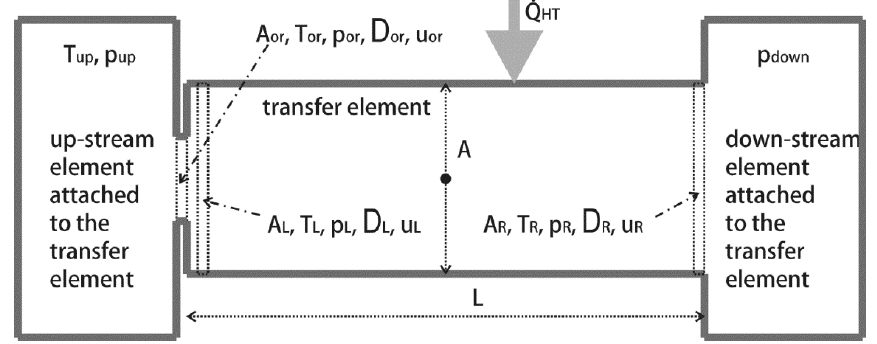
Figure 3. Scheme of the gas flow transfer element with the finite length consisting of the orifice followed by the element with length (cid:1838) [29].